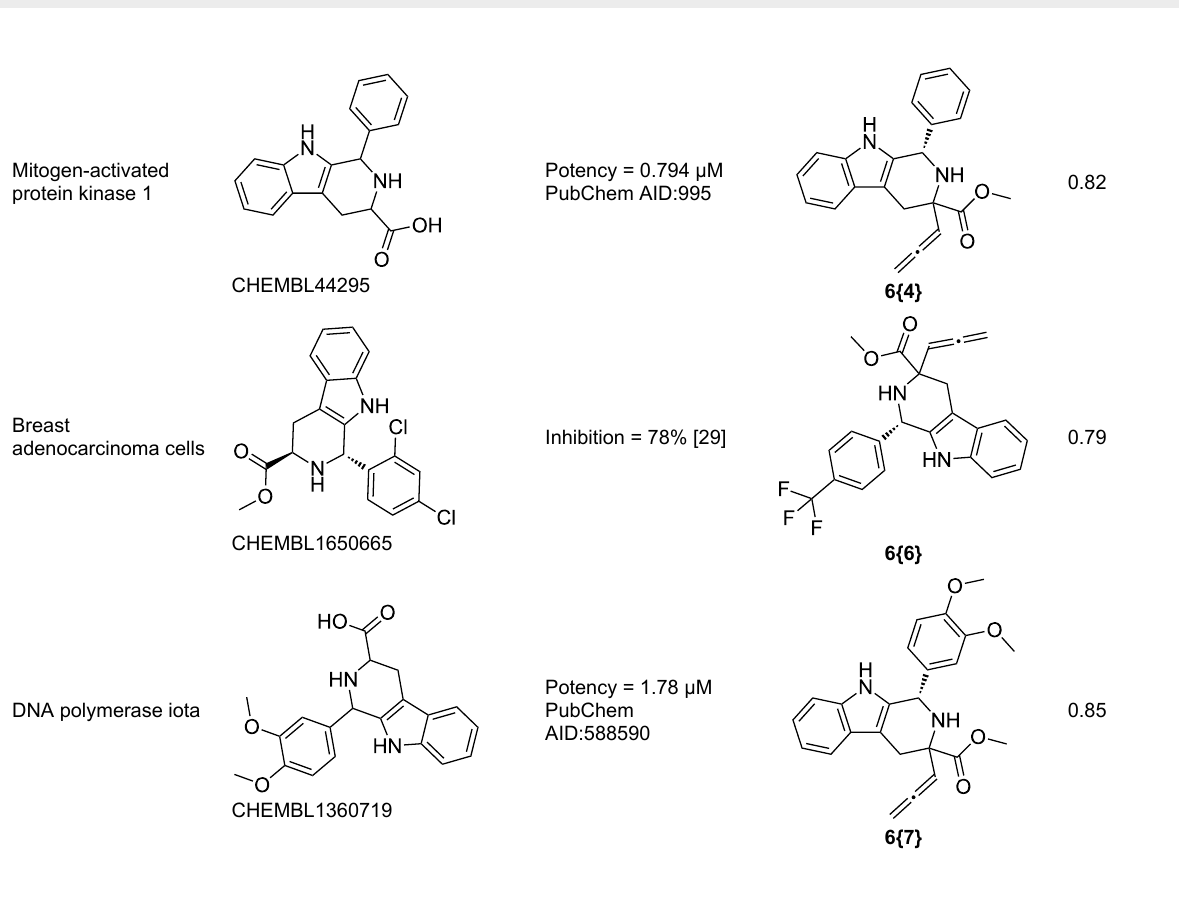
Table 4: Potential targets of β -carbolines based upon bioactivity data in ChEMBL. (continued)